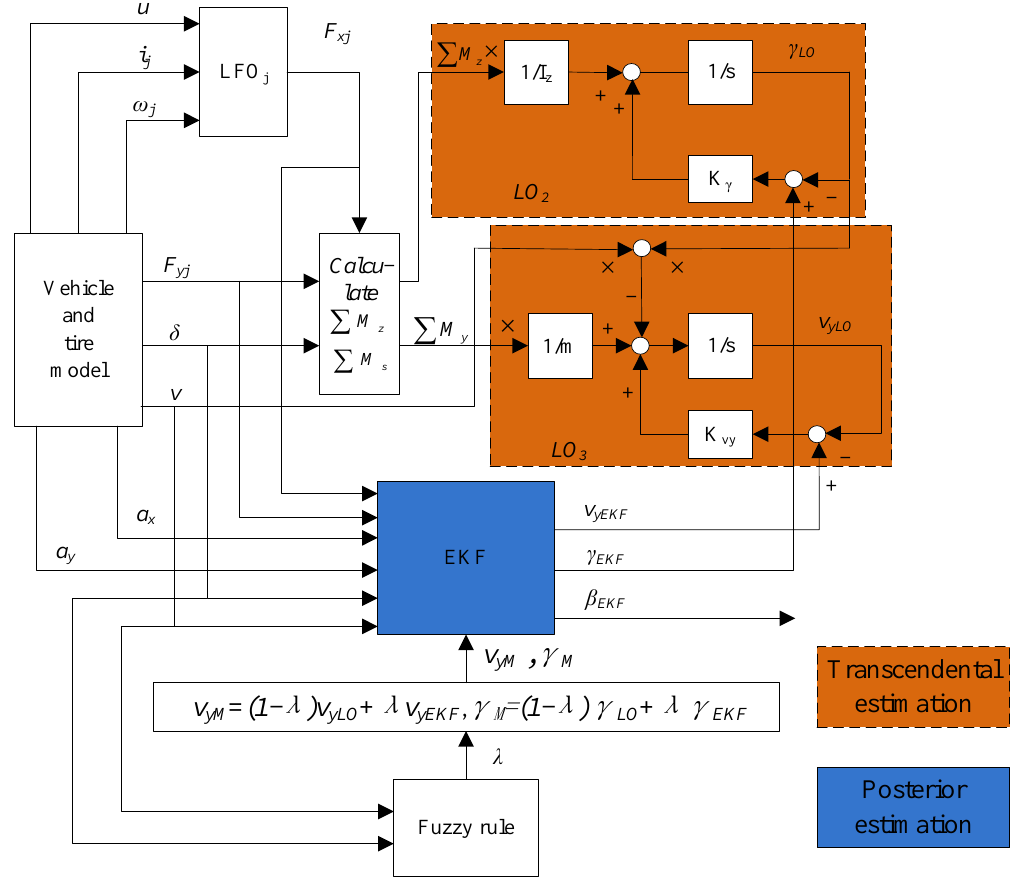
Figure 4. Architecture of the whole estimation method for vehicle state.